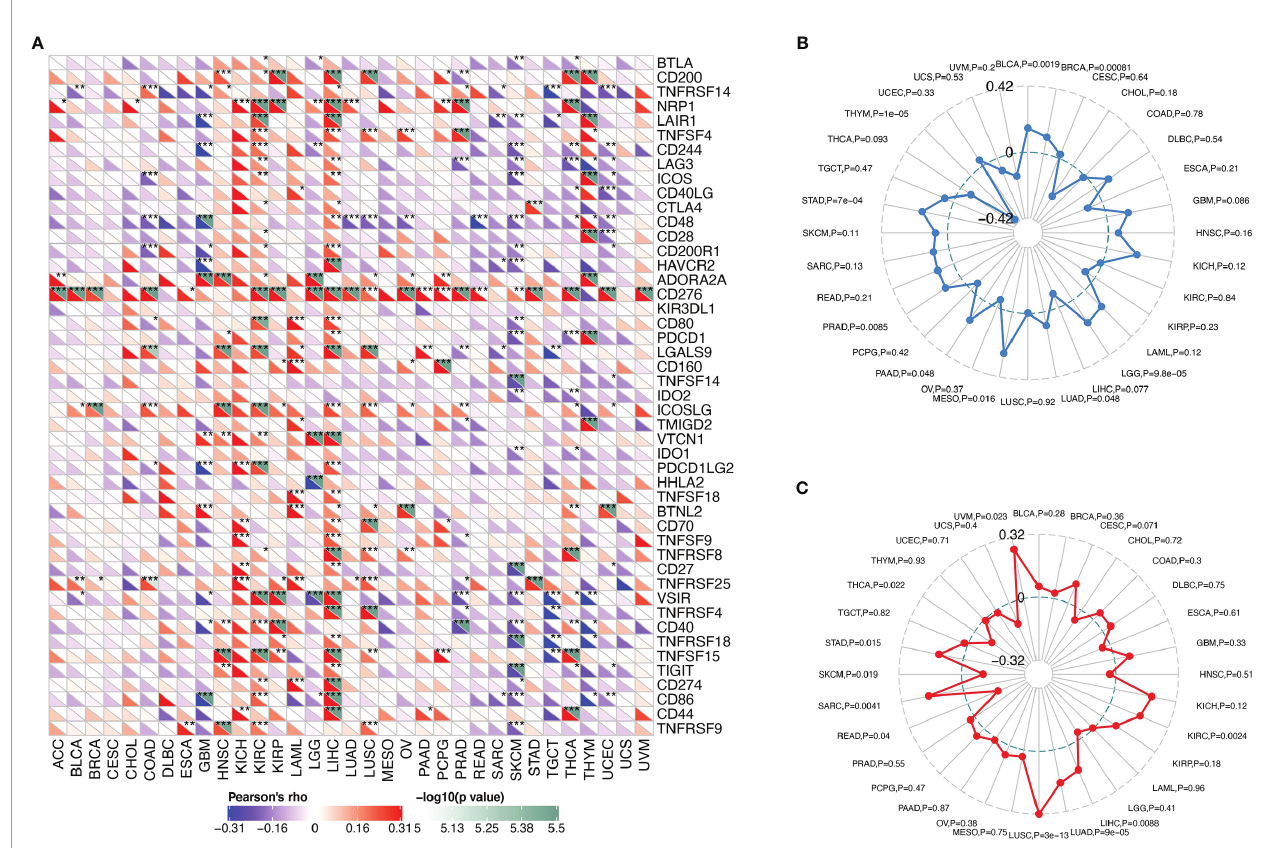
FIGURE 7 | Correlations between SMARCA4 expression and immunity, including immune marker sets, TMB, and MSI in cancers. (A) Correlation between SMARCA4 expression and immune marker sets. (B) Radar map of correlation between SMARCA4 expression and TMB. The value in black reveals the range, and the curve in blue reveals the correlation coef fi cient. (C) Radar map of correlation between SMARCA4 expression and MSI. The value in black reveals the range, and the curve in red reveals the correlation coef fi cient. * p < 0.05, ** p < 0.01, *** p <